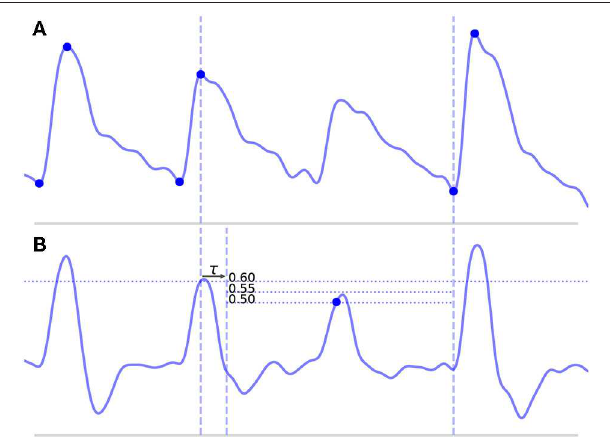
FIGURE 4 | Shown above is a long beat resulting from a missed onset due to a suppressed upslope. The x (time) and y (CBFV/MDF amplitude) axes have been normalized to dimensionless quantities. The CBFV signal is displayed in (A) , while the MDF signal is shown in (B) . Also shown in (B) are the threshold values used for onset detection, which are incrementally relaxed until either an onset is found or until some minimum threshold value is reached. The search window for the new onset is indicated by the vertical dashed lines once the refractory period τ has been